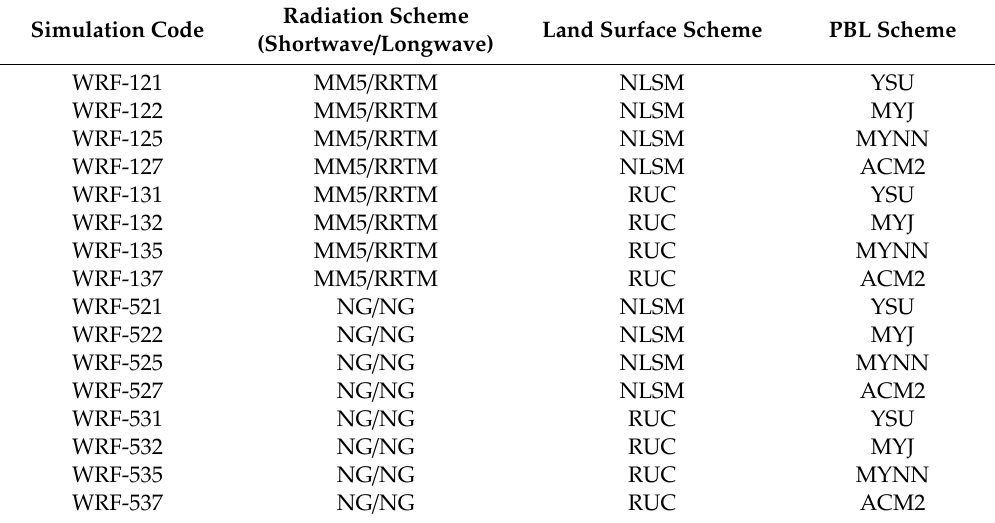
Table 2. Physical schemes used in each WRF